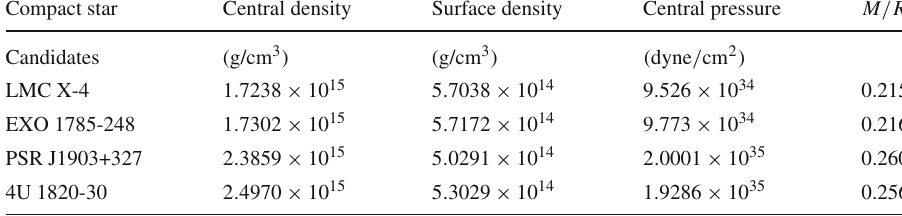
Table 2 The central density, Compact star Central density Surface density Central pressure M / surface density, central pressure and mass–radius ratio for compact star candidates